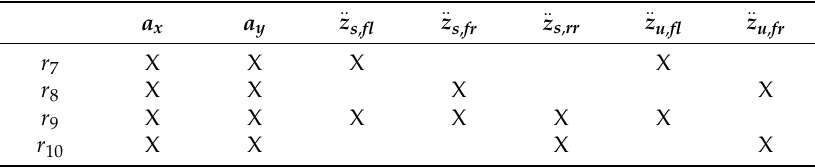
Table 3. Parameters semi-correlation table of normal force